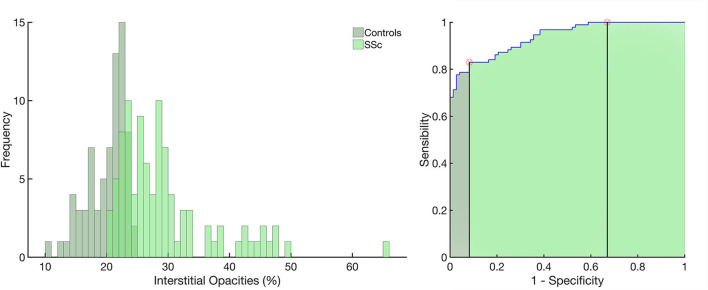
Left panel: histograms of the frequency of occurrence of interstitial opacities in the control group (light green) and in patients with systemic sclerosis (SSc, in dark green). Right panel: receiver operator characteristic curve with the area under the curve (AUC) hatched in light green. Vertical lines mark the normality cutoff (equivalent to 23.4% of total lung weight represented by interstitial opacites) and the Z score = 3 (equivalent to 29.6% of the total lung weight and used to classify SSc patients as with extensive interstitial lung disease, SSc-Extensive ILD). Between the normality cutoff up to Z score < 3, SSc patients were classified as with limited interstitial lung disease. Use of interstitial opacities as an indicator of ILD presented 0.83 sensitivity, 0.92 specificity, with an receiver operator characteristic curve with the area under the curve of 0.94; 95% from CI 0.89–0.96 (p < 0.001) and 0.93 positive predictive value and 0.81 negative predictive value.